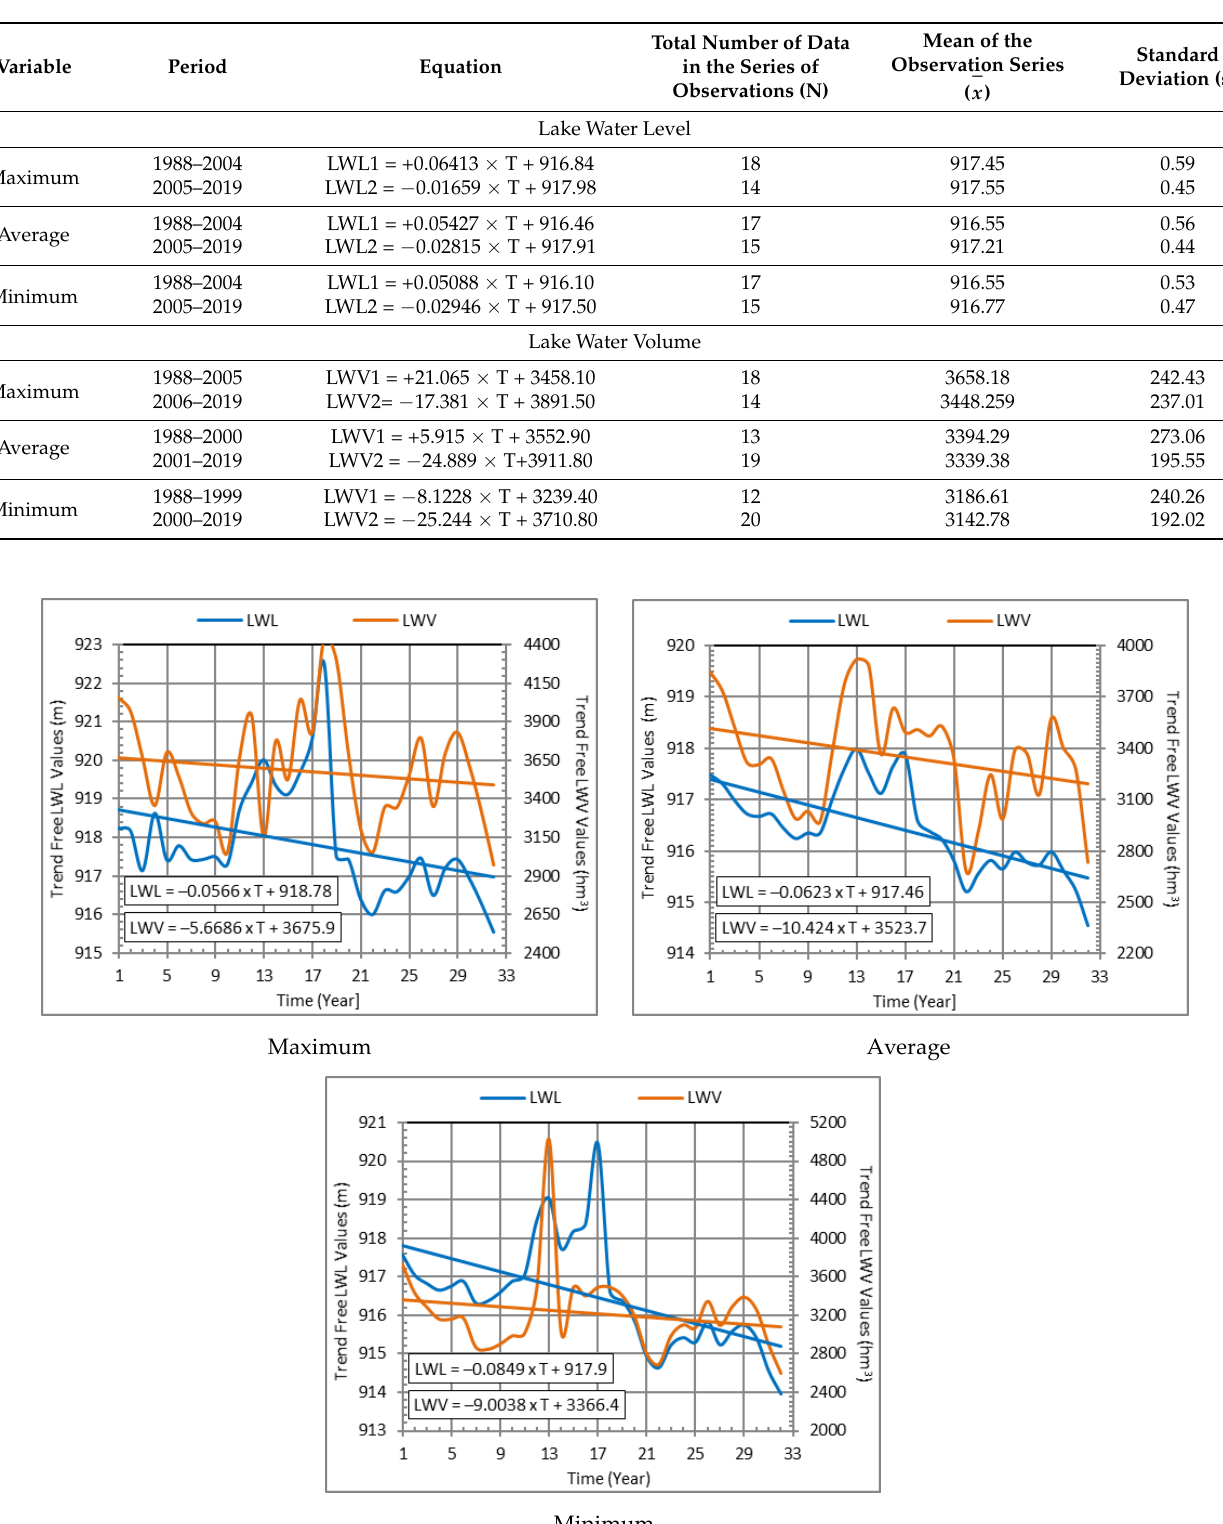
Table 3. Linear regression analysis equations for the different periods of the annual LWL and LWV series.